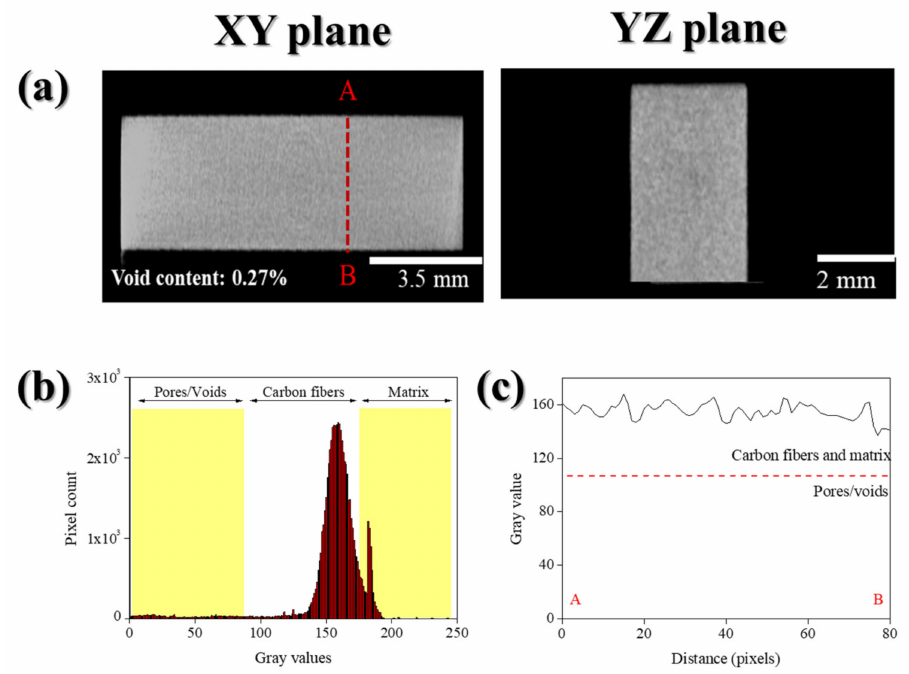
Figure 7. Tomographic slices of CF/PPS composites (processing temperatures of 280 ◦ C): ( a ) X-ray computed tomography image, ( b ) histogram, and ( c )